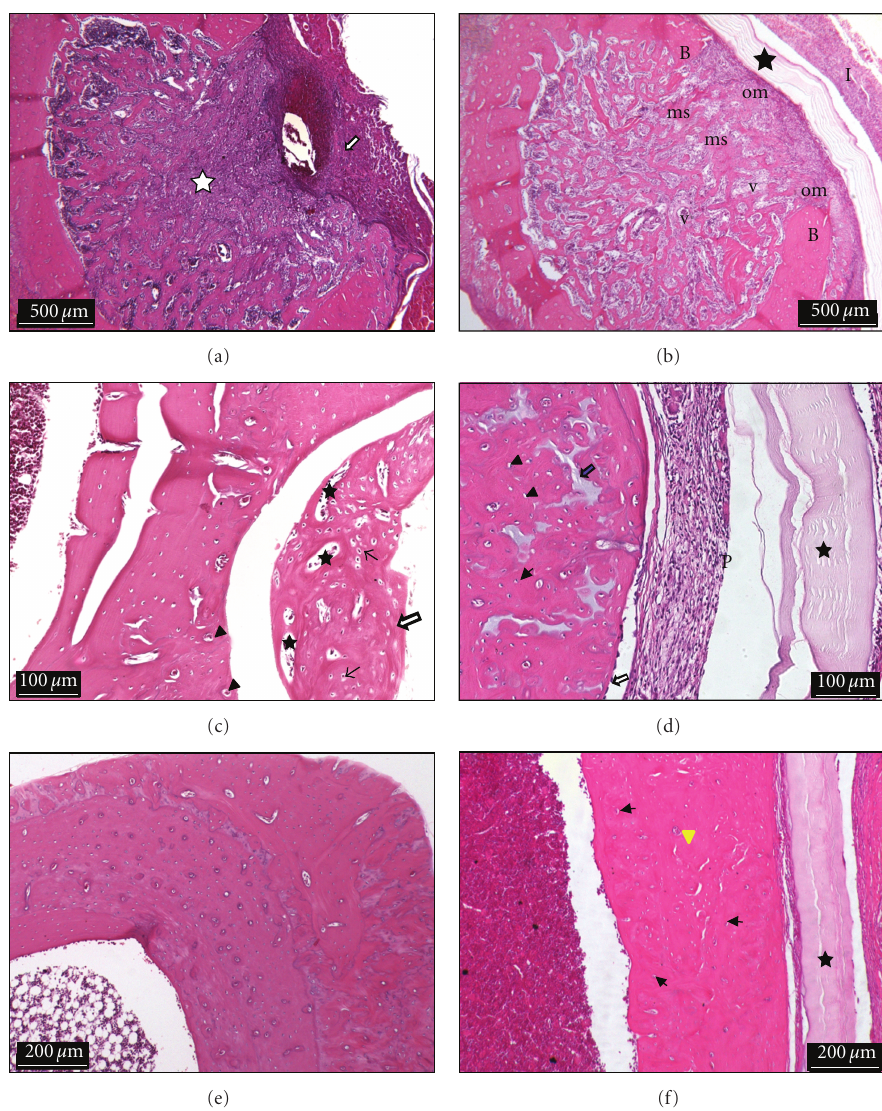
Figure 5: Histological photomicrographs: (a) Control group: 1 week. Bone defect filled by fibrotic tissue (white star); inflammatory infiltrate (white arrow). Hematoxylin-eosin staining (HE), scale bar (500 μ m); (b) Treated group: 1 week. Bone defect filled by newly formed bone, osteoids (om), medullary spaces with mesenchymal cells (ms), and several blood vessels (v); mature bone (B); BC-HA membrane (black star); inflammatory infiltrate (I) (HE), scale bar (500 μ m); (c) Control group: 4 weeks. New formed bone tissue is observed with several osteocytes (black arrows), blood vessels (arrow heads), and medullary spaces (stars); bone defect is not filled completely (white star) (HE), scale bar (100 μ m); (d) Treated group: 4 weeks. BC-HA membrane (star), periosteum (P), osteoblasts (white arrow), osteocytes (arrow heads), and bone matrix (blue arrow) (HE), scale bar (100 μ m); (e) Control group: 16 weeks. Mature bone (HE), scale bar (200 μ m). (f) Treated group: 16 weeks. BC-HA membrane (star); bone defect completely repaired by mature bone, osteocytes (black arrows), and blood vessels (arrow head) (HE), scale bar (200 μ